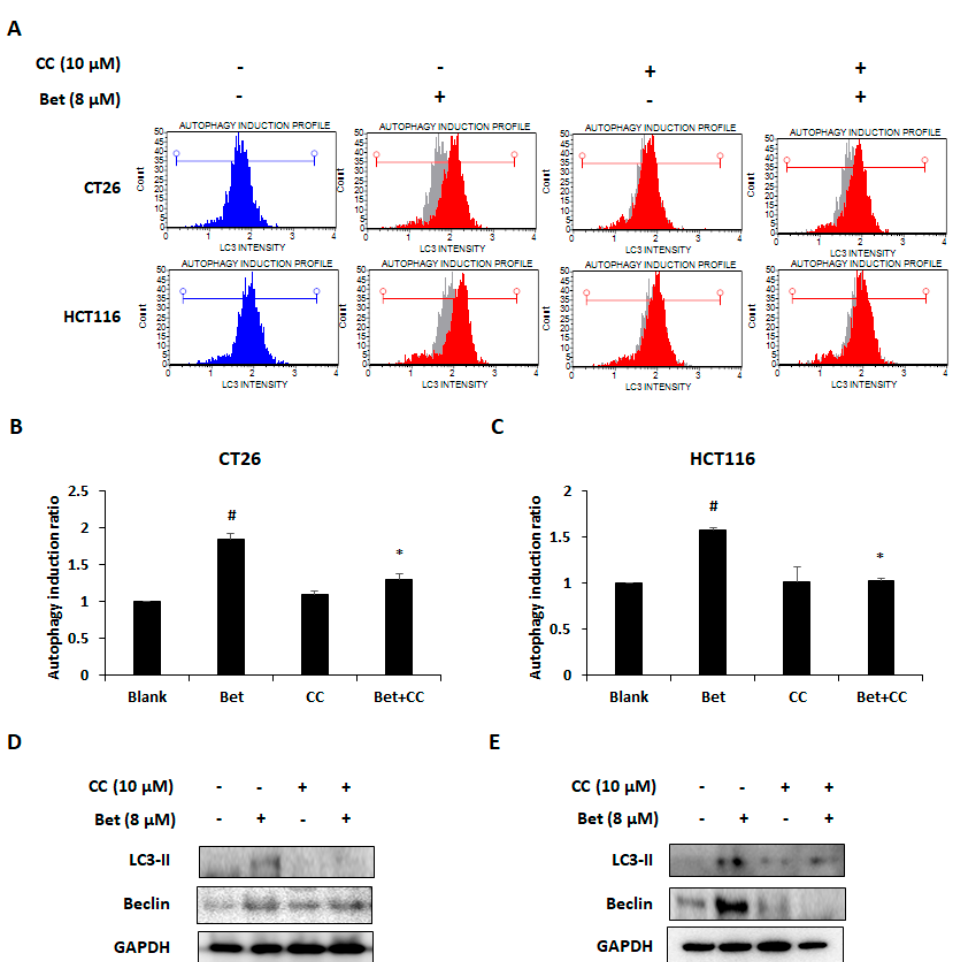
Figure 5. Betulin-induced AMPK activation is related to autophagy of metastatic colorectal cancer cells. ( A ) LC3 detection in betulin-treated CT26 and HCT116 cells after compound C (CC) treatment as detected by flow cytometry. Autophagy induction ratio of CT26 ( B ) and HCT116 ( C ) cells after betulin and CC treatment. Autophagy induction ratio was calculated by Muse Cell Analyzer. Expression changes of LC3-II and beclin-1 in betulin-treated CT26 ( D ) and HCT116 ( E ) cells. Images represent three independent experiments. Data are means ± standard deviation of three independent experiments. # p < 0.05 versus blank and * p < 0.05 versus betulin alone.